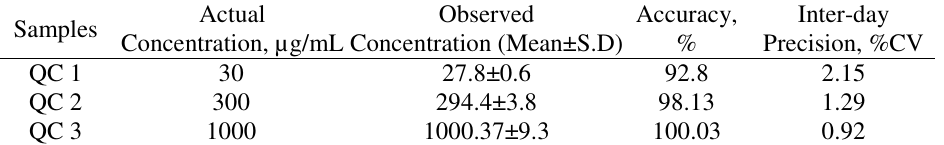
Figure 2(a). Chromatogram of valdecoxib free (blank) plasma (Retention Time: 2.833 min.) Figure 2(b). Chromatogram of an extracted plasma sample from a drug recipient containing valdecoxib (150 µg/mL) along with internal standard (50 µg/mL), [Retention Time:8.783 and 11.250 minutes for internal standard and valdecoxib respectively] Table 1. Precision and accuracy data for